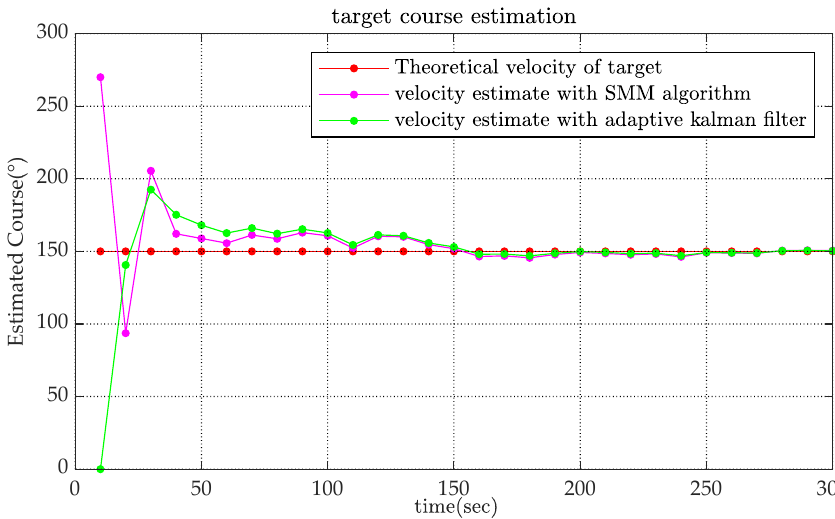
Figure 4. Comparison of estimated course.